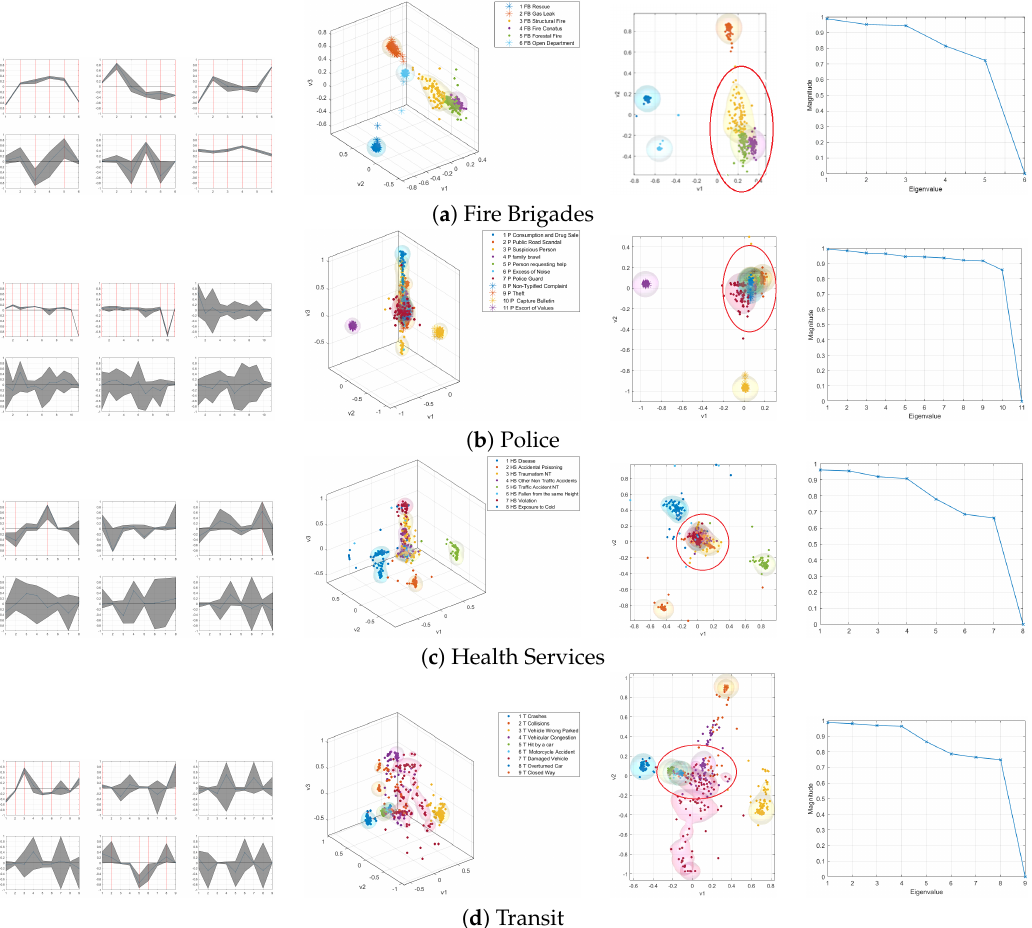
Figure 7. Individual MCA results of fire brigades, police, health service, and transit. See text for detailed